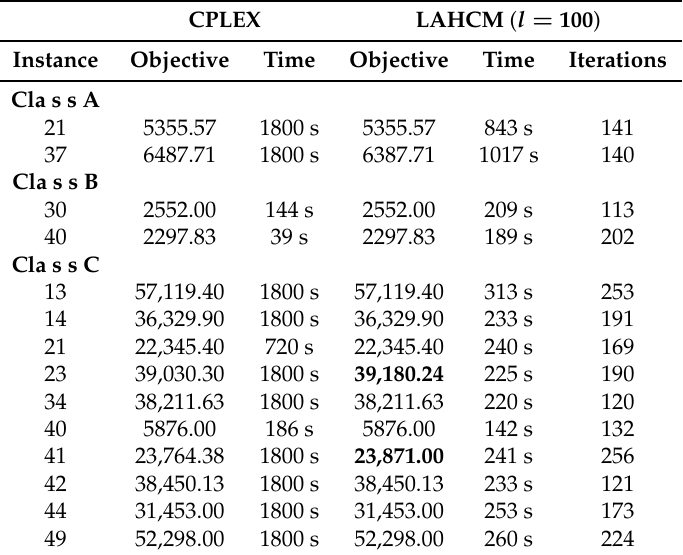
Table 13. Results for LAHCM with l = 100 for selected instances where no better solution could be provided in previous